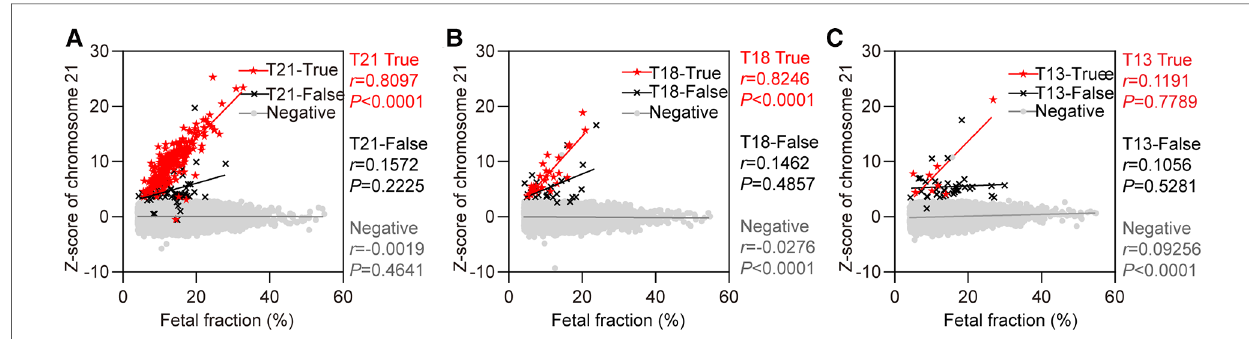
FIGURE 4 The relationship between z-score of chromosomes and fetal fraction. ( A ) Chromosome 21. Red solid fi ve-pointed stars represent false-positive cases ( n = 62). ( B ) Chromosome 18. Red solid fi ve-pointed stars represent false-positive cases ( n =25). ( C ) Chromosome 13. Red solid fi ve-pointed stars represent false-positive cases ( n